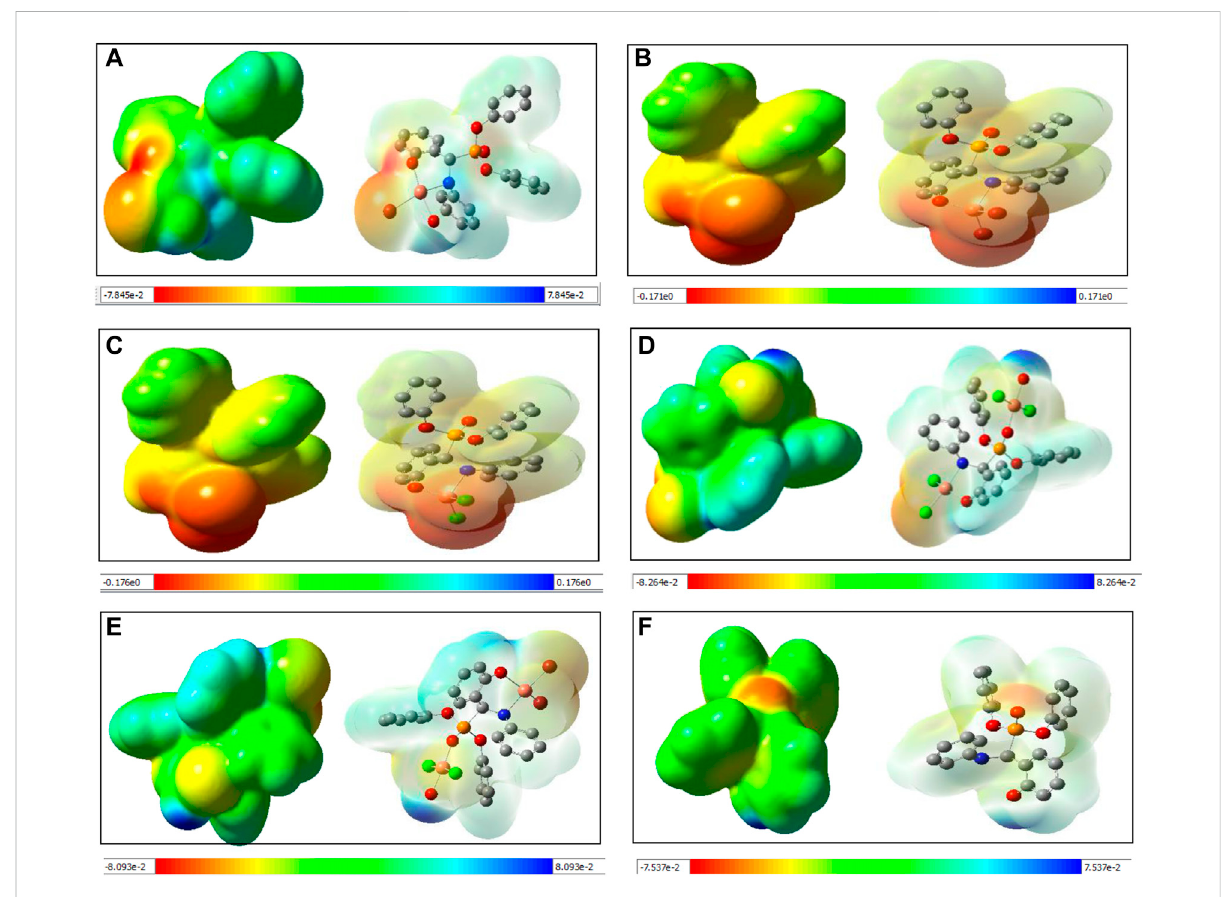
FIGURE 4 Computed molecular electrostatic potential maps (solid/transparent) of (A) species I , (B) species II , (C) species III , (D) species IV , (E) species V , and (F)